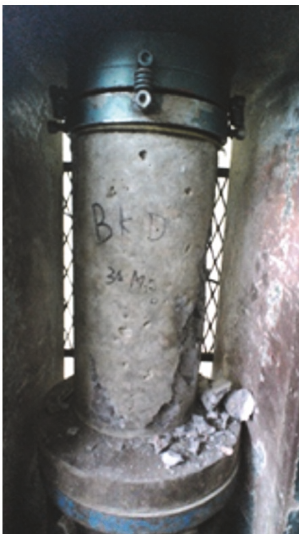
Figure 1: The process of compression testing.